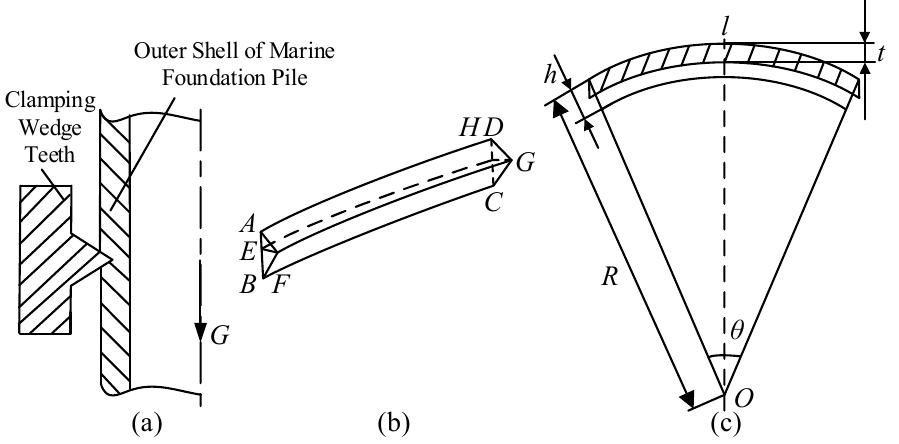
Figure 8. Interaction between Wedge Teeth of Clamping Mechanism and Pipe Wall of Foundation Pile. ( a ) Force exerted by single clamping teeth. ( b ) Single clamping tooth shape unit, ( c ) the geometric relationship between the wedge teeth and the foundation pile.